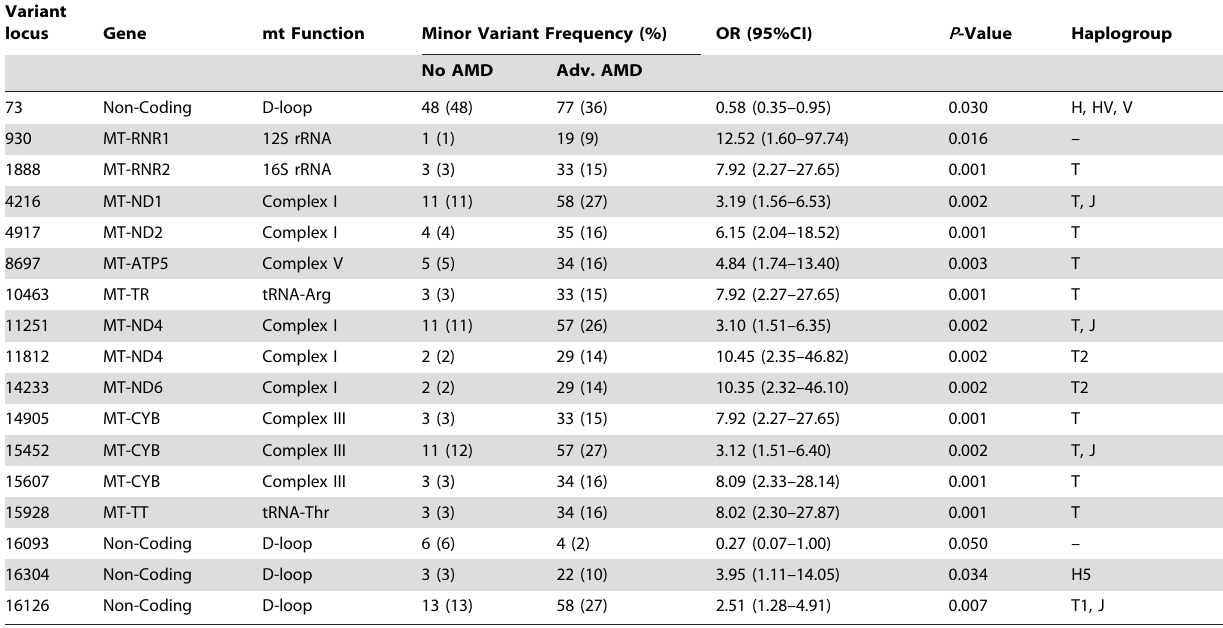
Table 1. Associations between mitochondrial variants and advanced